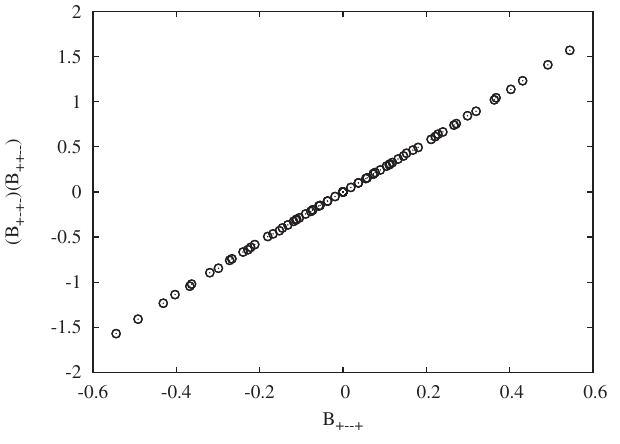
FIG. 4. B þ(cid:3)þ(cid:3) B þþ(cid:3)(cid:3) vs B þ(cid:3)(cid:3)þ for points on a 18 mm by 10 mm grid with button intensity computed with the map of button signal vs beam position. Deviation from the superimposed straight line, barely evident at even the largest amplitudes, shows the extent to which the higher than second order terms can be ignored. The units are arbitrary.